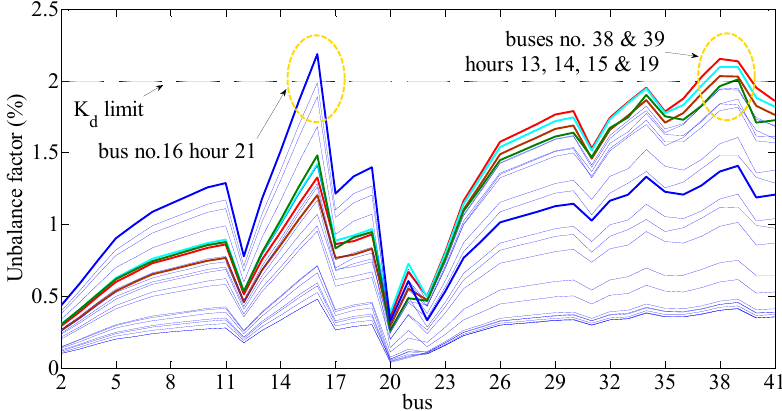
Figure 4. Case Study 1: Unbalance factor at each hour of a summer typical day.